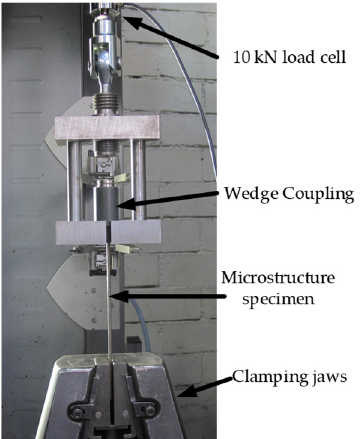
Figure 4. Test setup “tension test” of microstructure specimens.